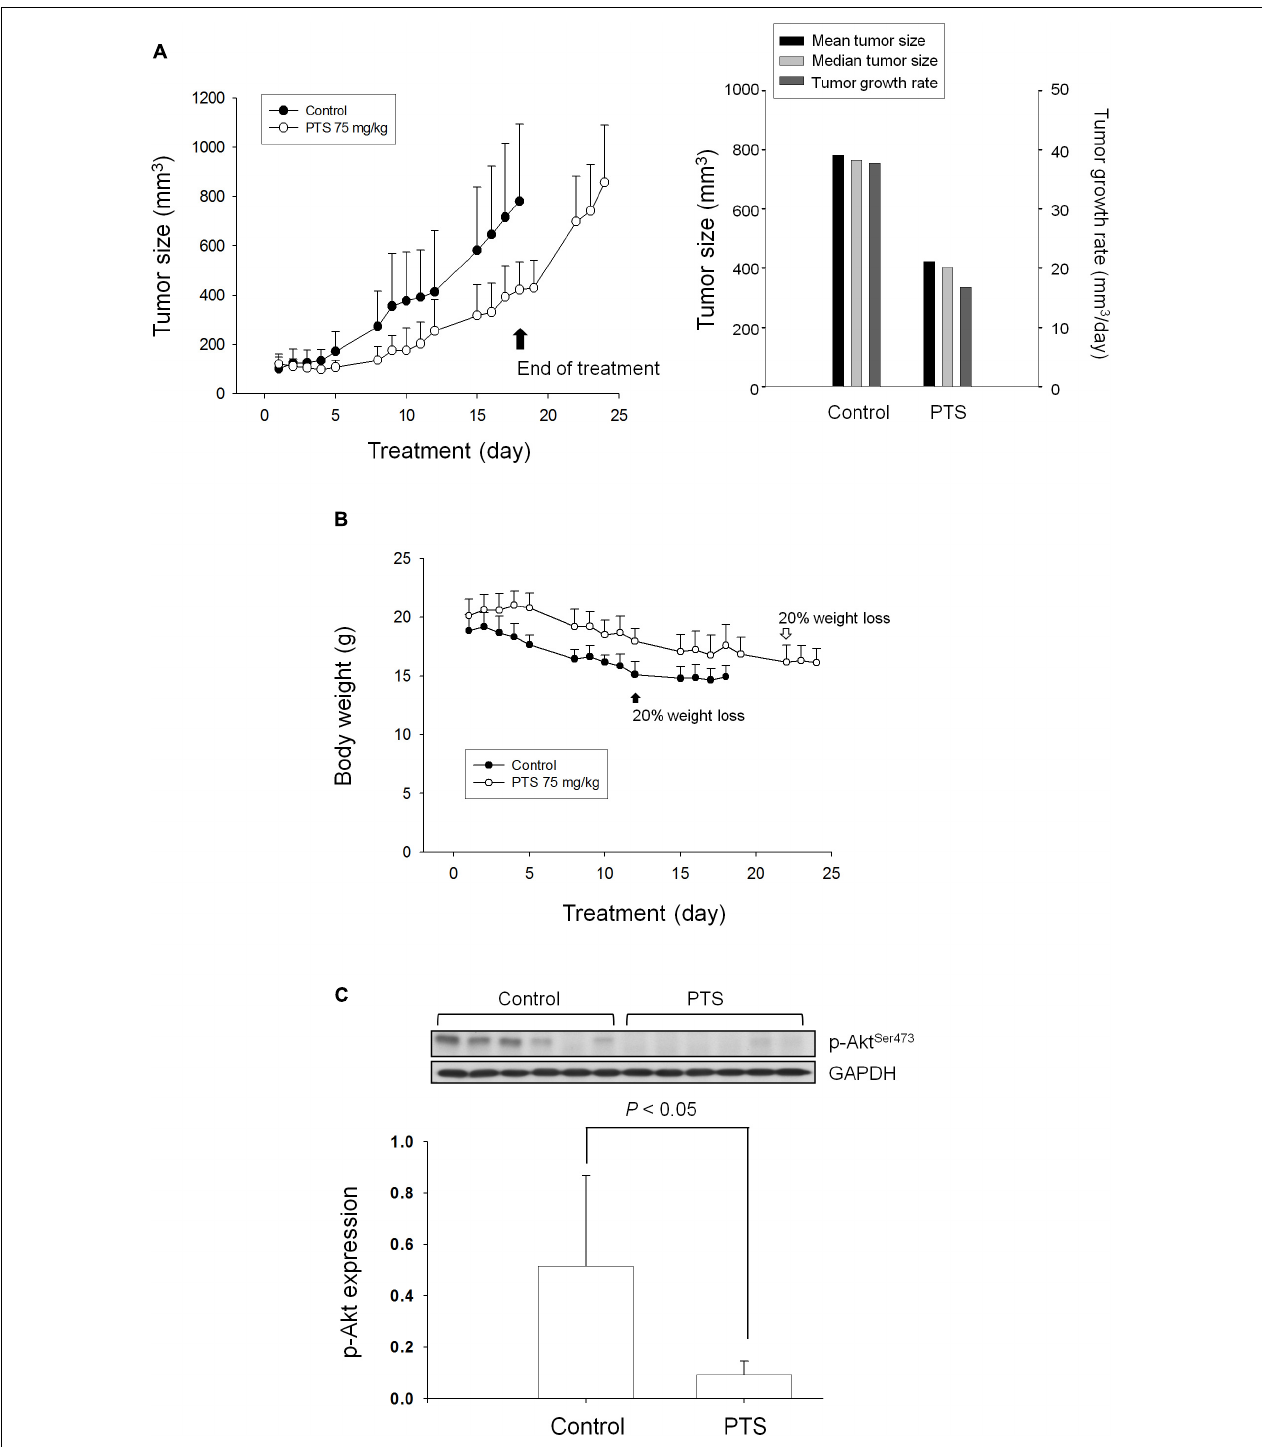
FIGURE 7 | Effect of PTS in an in vivo anti-tumor xenograft model. The nude mice were subcutaneously injected with PC-3 cells (10 7 cell/mouse). The tumors were measured every day. When the tumors reached to a volume of 100 mm 3 , the mice were divided into two groups and intraperitoneal PTS injection was initiated. (A) The length ( l ) and width ( w ) of the tumor were measured, and tumor volume was calculated as lw 2 /2. (B) The body weight was also measured. The protocols of the in vivo study were approved by the Animal Care and Use Committee at National Taiwan University. All animal procedures and protocols were approved by AAALAC-accredited facility. (C) The p-Akt expression of randomly selected six tumors in both control and PTS groups has been detected. Data are expressed as mean ± SD.